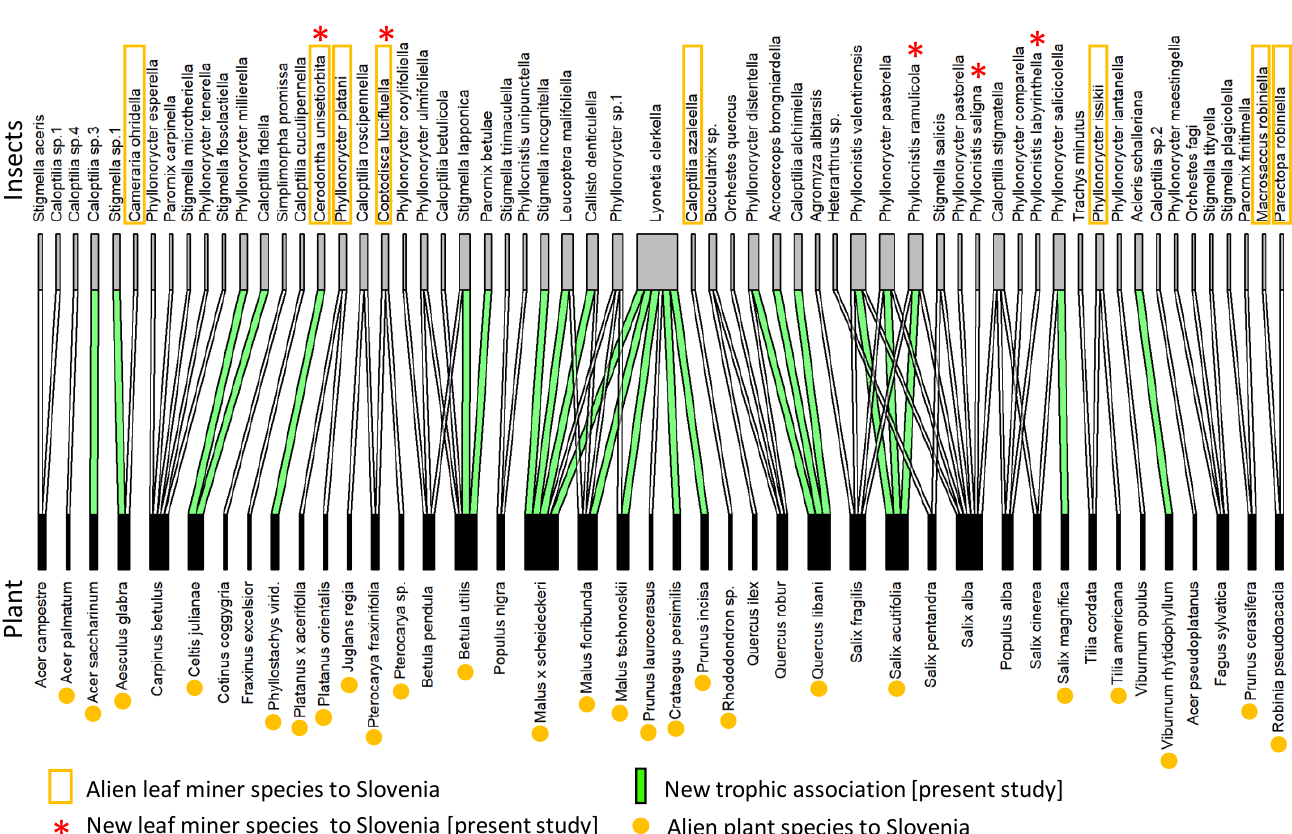
Figure 5. Trophic relationships between leaf-mining insect species and woody plants in the Volčji Potok Arboretum (Slovenia). Cut name in the figure: Phyllostachys virid.—Phyllostachys viridiglaucescens.